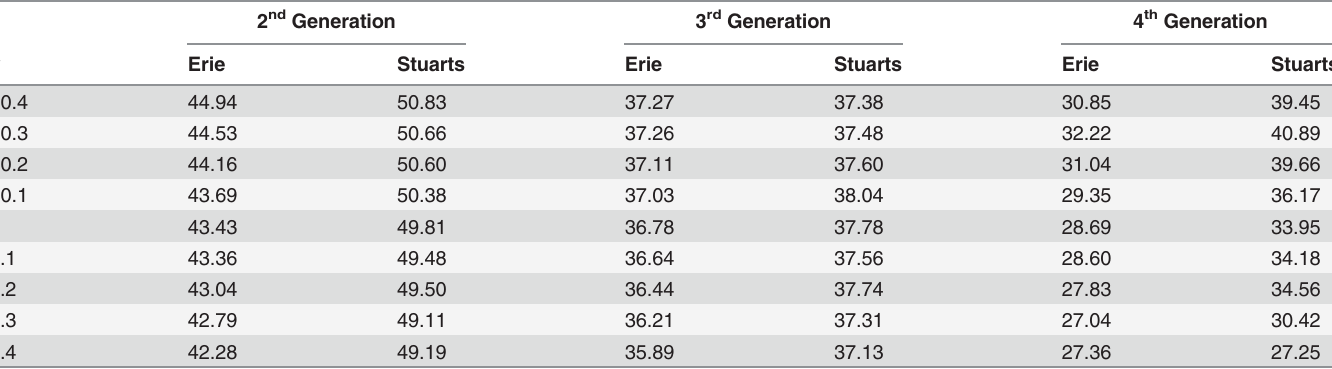
Table 2. Mean Duration (Days) of Each Generation at Different Locations under the Same Mean Temperature with Various DTR Conditions. 2 nd